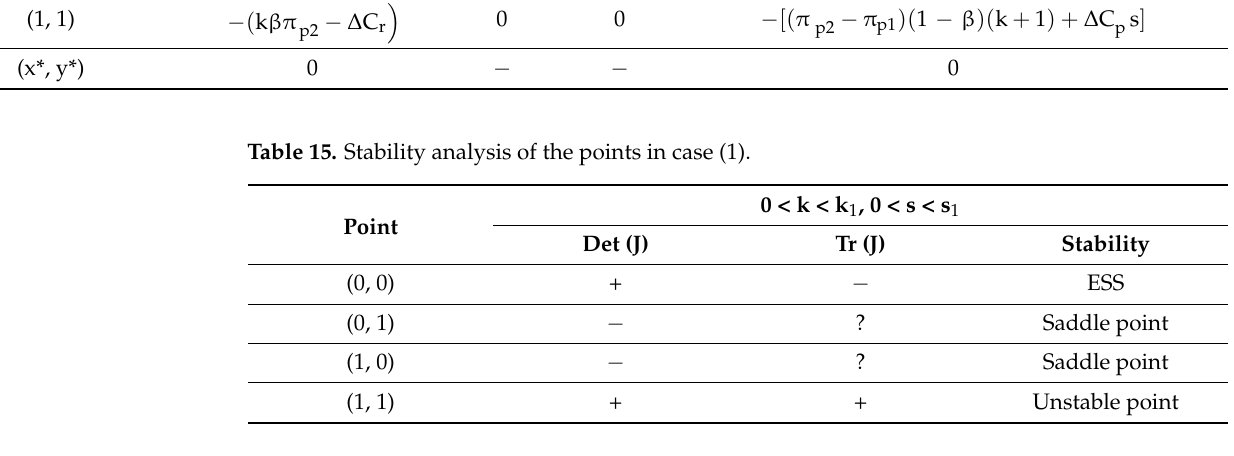
Table 16. Stability analysis of the points in case (2).